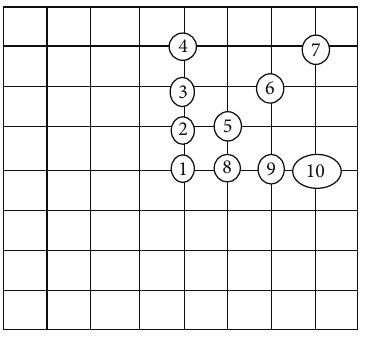
Figure 3: Points at which deflection is